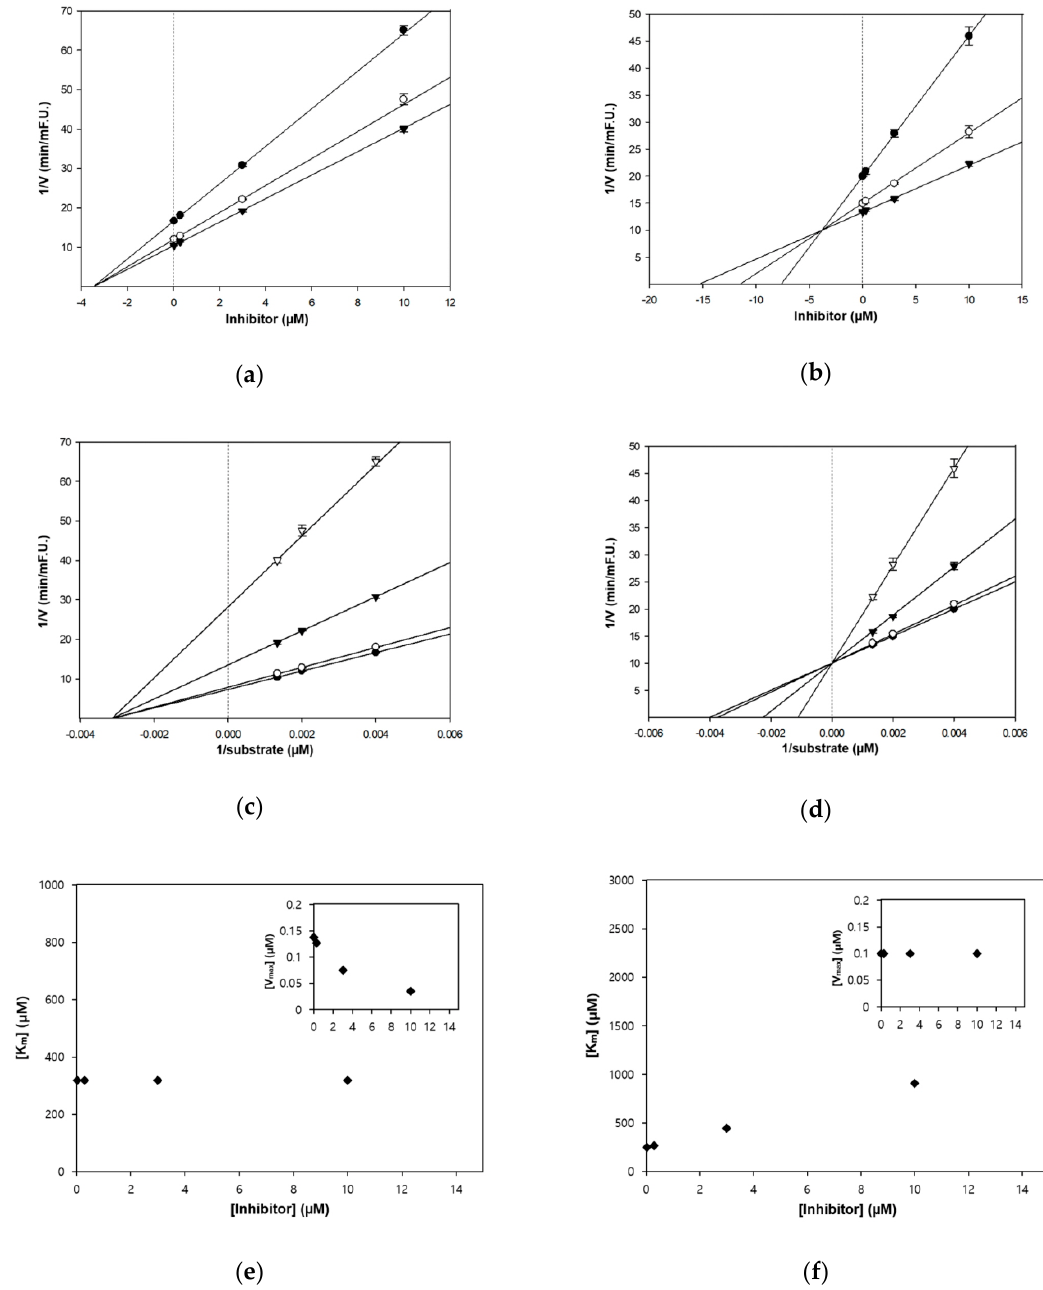
Figure 2. The kinetics of AChE and BChE inhibition by zerumbone. Dixon plots represent the effects of increasing substrate concentrations: 250 µM ( ● ); 500 µM ( ○ ); and 750 µM ( ▼ ) for zerumbone ( a ) and ( b ). Lineweaver–Burk plots were evaluated in the presence of the inhibitor at different concentrations: 0.03 µM ( ● ); 0.3 µM ( ○ ); 3 µM ( ▼ ); and 10 µM ( ▽ ) for zerumbone ( c ) and ( d ). The Km values, and the dependence of the values of Vmax, on the concentration of zerumbone ((Inset) ( e ) and ( f )).